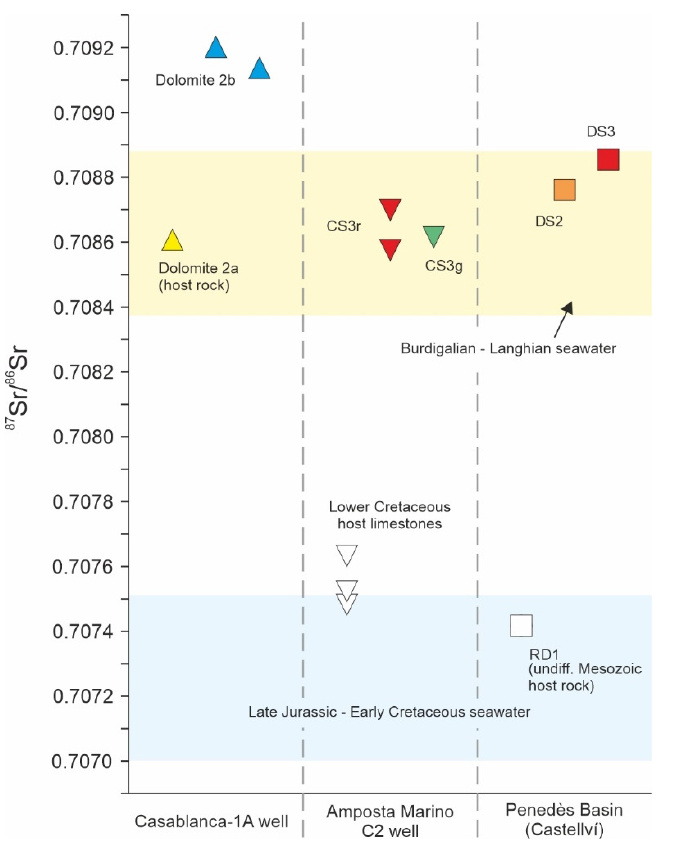
Figure 12. δ 18 O vs. δ 13 C of the karst fills and host carbonates in the Casablanca and Amposta oil wells and in the Penedès Basin.